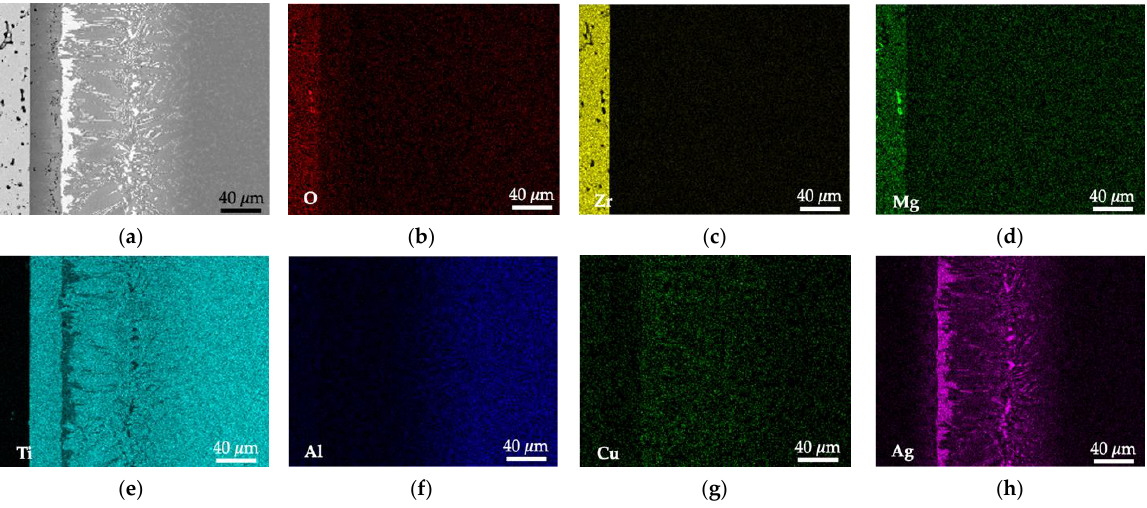
Figure 4. ( a ) SEM image and (EDS) elemental distribution maps of ( b ) O, ( c ) Zr, ( d ), Mg ( e ) Ti, ( f ) Al, ( g ) Cu and ( h ) Ag of the brazed interface of ZrO 2 /Ti6Al4V joint processed at 980 °C. To identify the possible phases constituting the reaction layers formed at the interfaces, EDS chemical analyses results and SEM images of the interfaces were combined with the information provided by the Ti-Al [18], Ti-Al-Ag [19,20], Ti-Ag-Cu [19], Ti-Al-V [21], Ti-Al-Nb [22] and Ti-Al-Cu [23] equilibrium phase diagrams. Figure 5 presents SEM images of the interfaces showing typical detailed microstructural features for the three brazing temperatures. The EDS analysis results of each zone marked in these images are shown in Table 1.